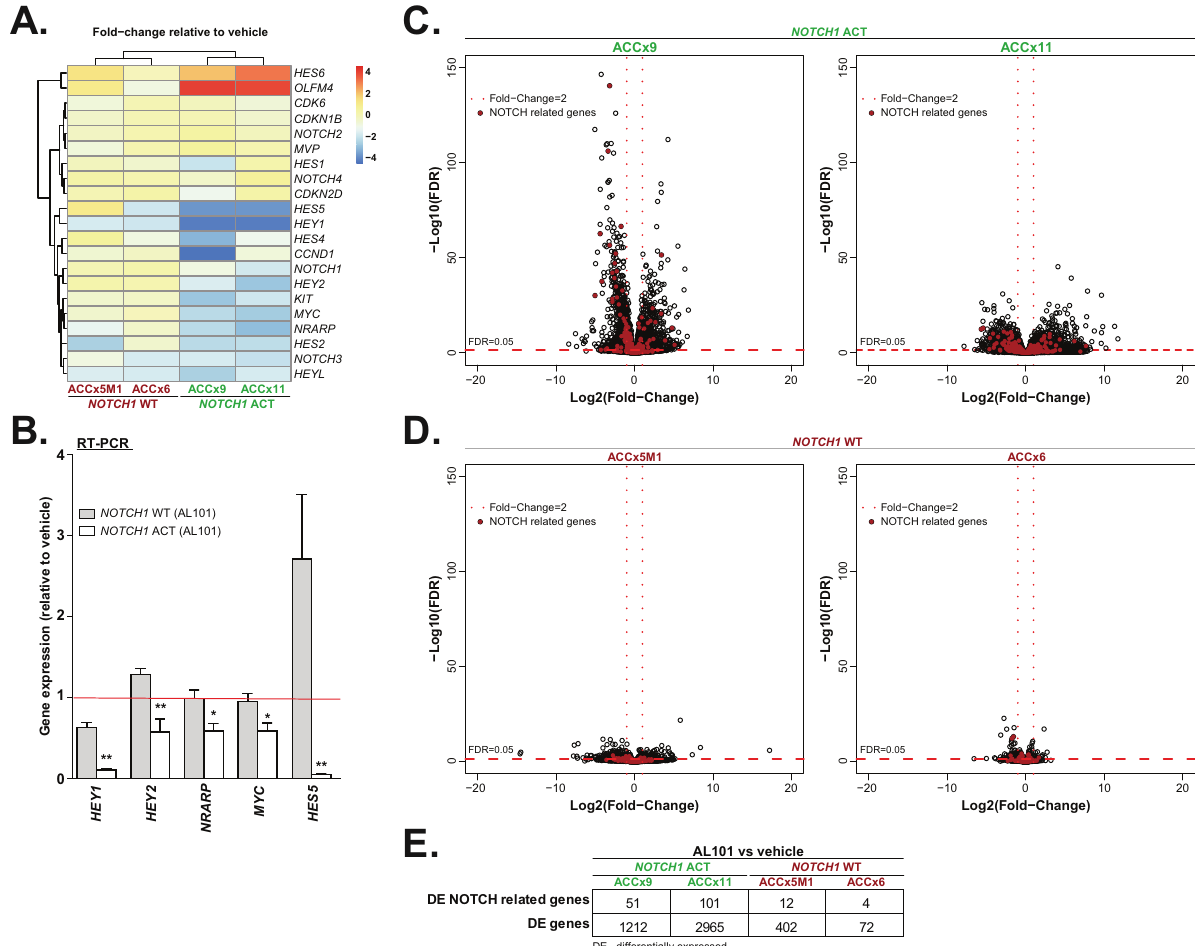
Fig. 5 AL101 inhibits NOTCH-mediated tumorigenic signaling in vivo. A Fold-change in expression of 21 NOTCH-related genes (from normalized RNA-seq data) in animals treated with AL101 relative to vehicle-treated animals, displayed as a hierarchical clustering heatmap. Increased and reduced expression of genes is indicated with shades of red or blue cells, respectively. B Con fi rmation of RNA-seq data with RT- PCR analysis of selected NOTCH target genes in AL101-treated relative to vehicle-treated animals (red line). Gray bars: animals carrying wild- type NOTCH1 alleles; white bars: animals harboring NOTCH1 activating mutations. * p < 0.05, and *** p < 0.01. C , D Volcano plots depicting gene expression changes in AL101 versus vehicle-treated animals. The red circles represent genes included in a 478 NOTCH-related geneset curated from KEGG, PID, MSigDB, and PathwayCommons databases (see Supplementary Table 1 for details). E The table summarizes the total number of differentially expressed (DE) genes and NOTCH-related DE genes in AL101-treated animals relative to vehicle-treated